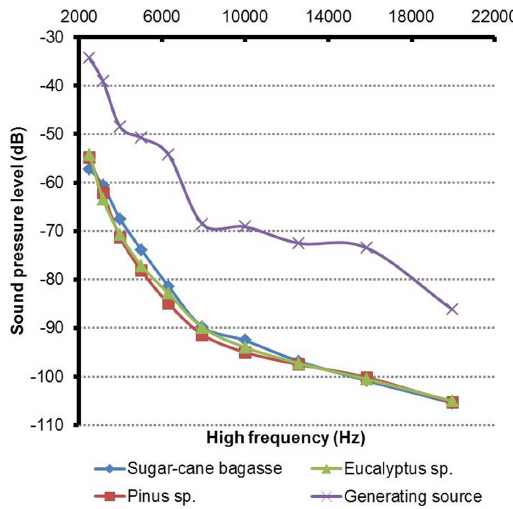
Figure 10. Sound pressure levels for high frequencies (2,000 – 20,000